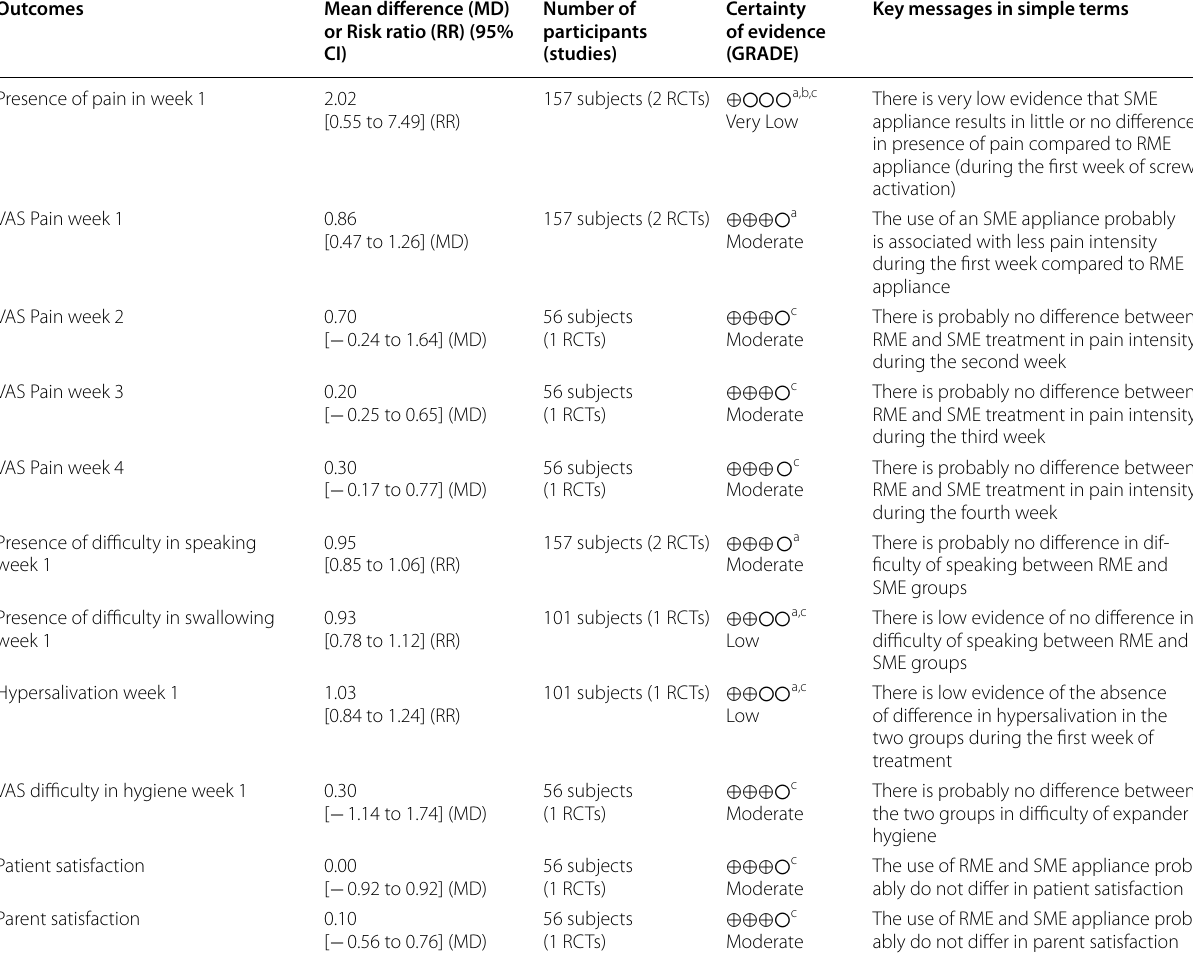
Table 5 Summary of Findings Table (SoF) for GRADE statement of included